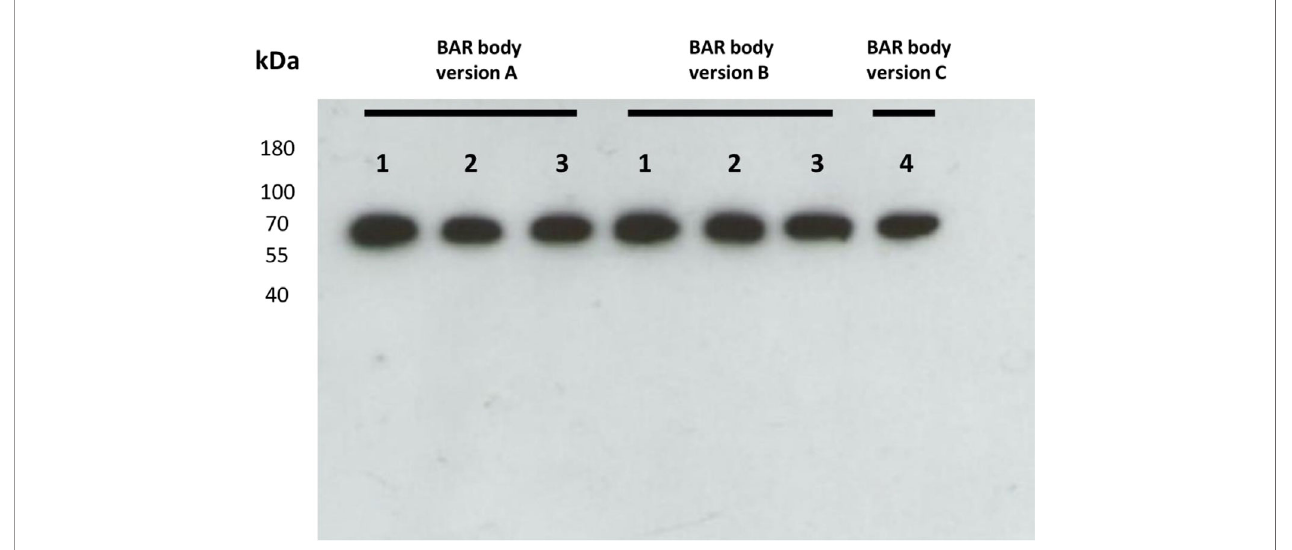
FIGURE 1 | Western blot of heavy-chain-only Fab-format neurabin-I BAR bodies after expression in TG1 E. coli bacteria. Fab-format neurabin-I BAR-bodies versions A, B [three clones each (1 – 3)] and C (single clone 4) were produced. All Fab-format BAR bodies had the expected molecular weight of approximately 67 kDa corresponding to 628 amino acids (1,884 base